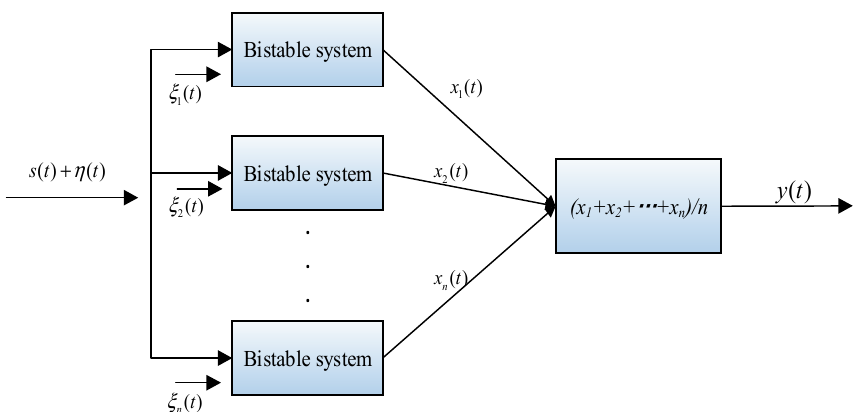
Figure 2. The structure of array bistable stochastic resonance system . It can be seen from Figure 2 that the input of each bistable array unit is a mixed signal η η of the same original input ( ) s t and noise ( ) t . ( ) t refers to white Gaussian noise with t ξ refers to the internal noise of each bista- mean value of 0 and noise intensity of D . ( ) i ble array subsystem. Each subsystem in the array can be represented by Langevin equa- tion, that is